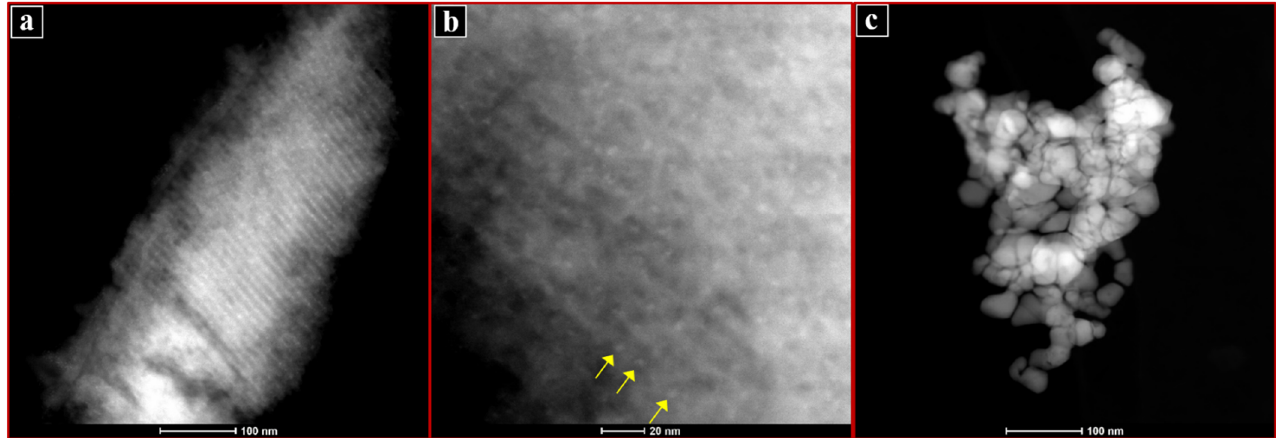
Figure 7. HAADF images of the catalyst SL-Pd after catalyst testing showing: ( a ) the ordered mesoporous carbon structure with few visible Pd particles; ( b ) Pd nanoparticles within the mesopore structure (examples arrowed); and ( c ) a large agglomerate of Pd metal.